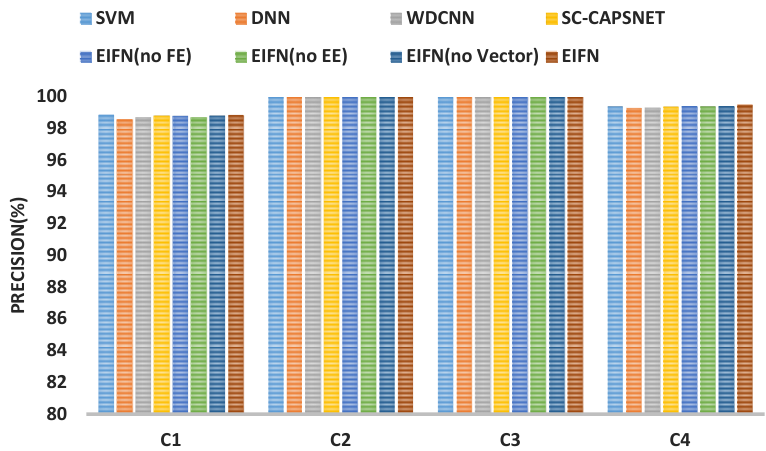
Figure 8. The result of bearing fault diagnosis on CWRU without noise. The abscissa is the dataset, and the ordinate is the precision of fault diagnosis.